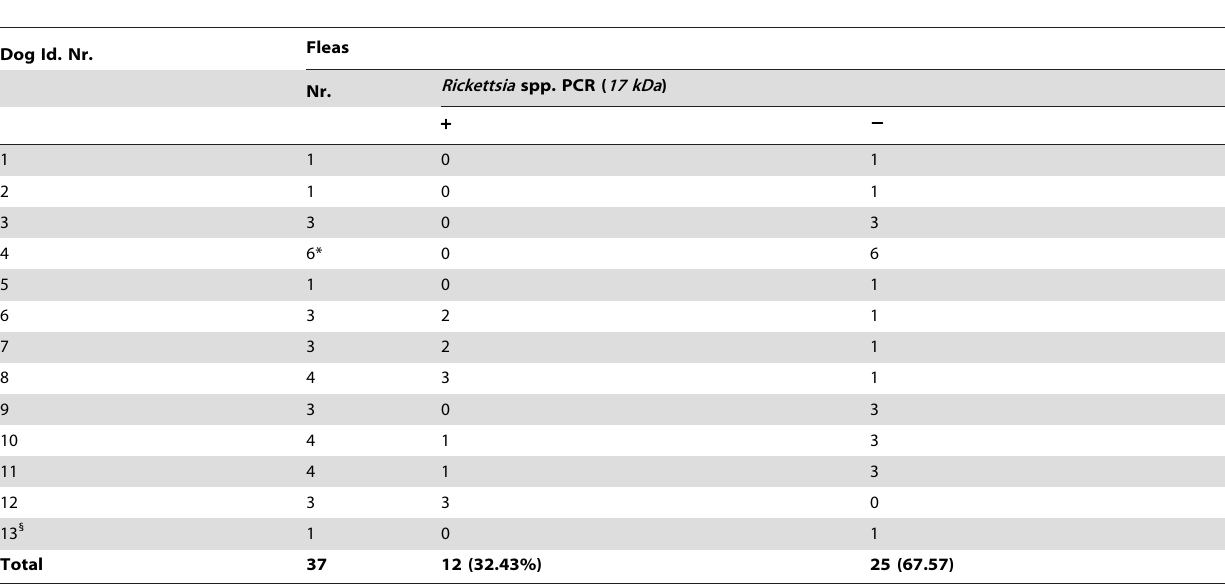
Table 1. Flea distribution on dogs ( 1 owned dog), with the results of Rickettsia spp. PCR performed on 37 fleas (*two C. canis ).